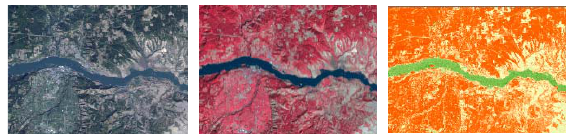
Figure 11. Mosaic dataset of RGB, False Color, and NDVI that reference the same source data